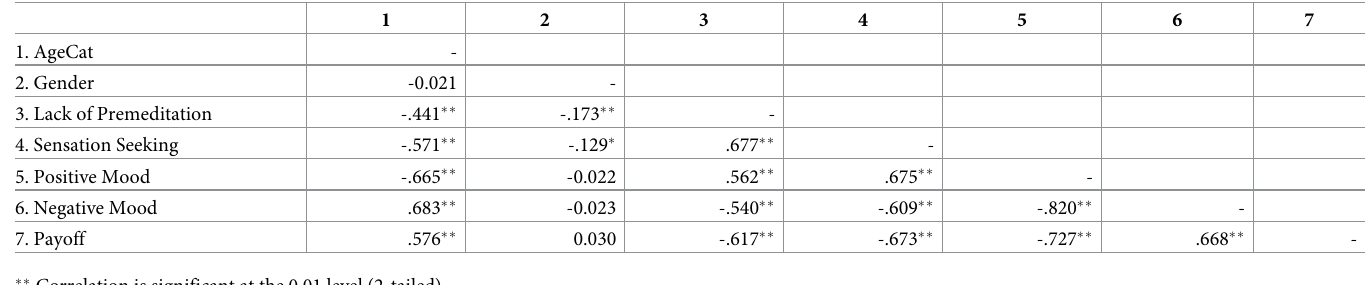
Table 2. Correlation